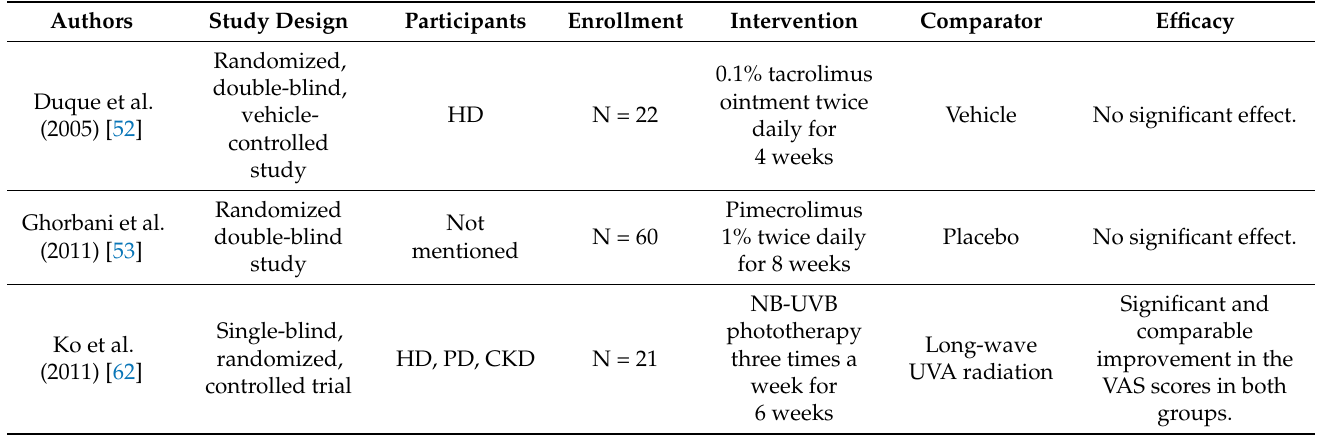
Table 1. Summary of studies of interventions for uremic